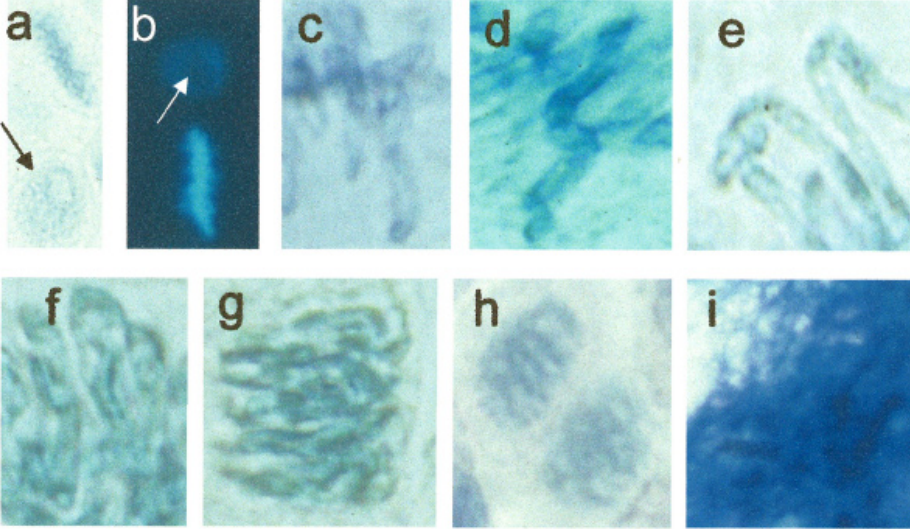
Fig. 2: Curved and compacted chromosomes during mitosis. a. Compacted metaphase compared with a loosened interphase nucleus (arrow). b. UV micrograph to visualize DNA of both metaphase and interphase (arrow). c. Transit from metaphase to anaphase with longer and shorter arms of diffuse chromosomes. d. Stretched chromosome with a zigzag configuration and condensed flavanols confined to distinct sectors. e. Curved chromosomes during anaphase with pale blue and moderate blue sectors. f. Semicircles of chromosomes during anaphase. g. One daughter cell at early telophase shows bending and intermingling chromosomes with variable density of flavanols. h. Diffuse early telophase configuration. i. DNA (calf thymus) incubated in watery EGCG solution (20